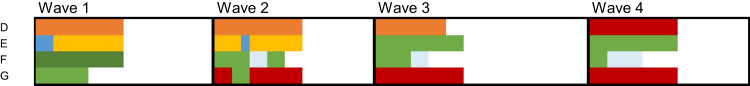
Examples of full modal shift patterns. Each horizontal line is an individual. The waves are separated by vertical black lines. Each trip is one square, individually colour-coded and the length of the line corresponds with the number of commute trips made over one week. Each colour represents one modal combination. Orange = car only; green = bicycle only; blue = walk only; red = motorcycle; yellow = train only; and brown = bus only. The white colour indicates no trip was made. Full legend: see Appendix D. (For interpretation of the references to color in this figure legend, the reader is referred to the web version of this article.)